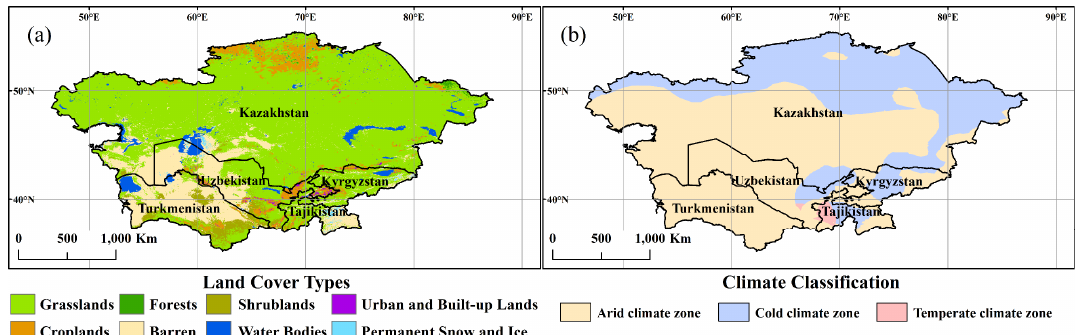
Figure 1. ( a ) The land cover types (Source: MCD12Q1, https://modis.gsfc.nasa.gov/data/, accessed on 20 September 2021), and ( b ) the climate classification in the study area.